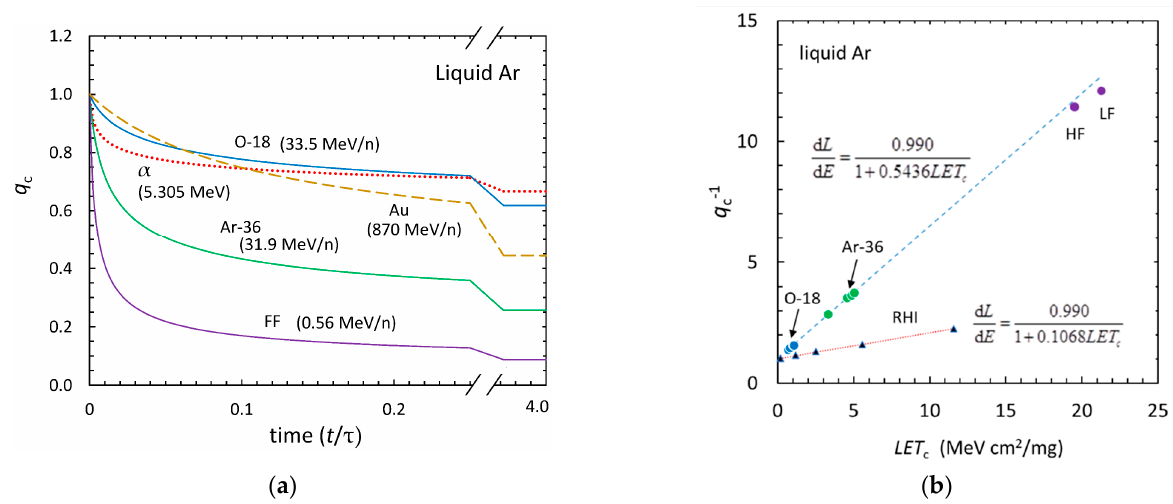
Figure 3. Calculated quenching in liquid argon. ( a ) Evolution of quenching in the track core produced by α -particles, Au, 18 O, 36 Ar and Ba ions (as heavy fission fragments). The ratio of the number of self-trapped excitons with and without quenching as a function of time is plotted. The initial radii are a 0 = 0.39 and 5.8 nm for α -particles (dotted curve) and Au ions (dashed curve), respectively. a 0 values for 18 O, 36 Ar and Ba ions (solid curves) are ~1.5 nm. ( b ) The inverse of q c calculated for 18 O, 36 Ar, Mo (LF) and Ba (HF) ions plotted as a function of core LET. Birks’ law was used to fit values for 18 O and 36 Ar ions. Birks’ law applied for RHIs is also shown ( a 0 = 5.4–6.2 nm).